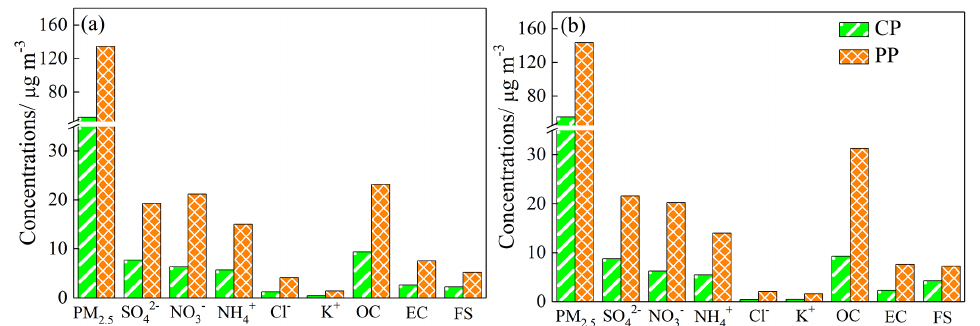
Figure 6. PM 2 . 5 and major chemical components during clean periods (CP) and pollution periods (PP) in winter at CD (a) and CQ (b) . At CD: CP, 6 January and 27 January–2 February 2015; PP, 7–26 January 2015. At CQ: CP, 6–7 January and 27 January–2 February 2015; PP, 8–26 January 2015.